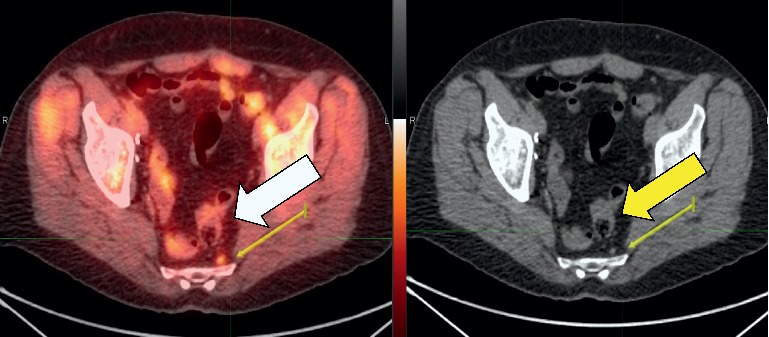
Images of a 68-year-old male with T3N0M0 prostate cancer. He had undergone radical prostatectomy, bilateral lymph node dissection, and salvage radiation therapy. He was referred for 18F-fluciclovine imaging with PSA rising to 0.7 ng/mL. The axial, fused PET/CT image on the left identifies a focus of enhanced 18F-fluciclovine uptake (white arrow) in the presacral region. The corresponding CT image on the right identifies a 6-mm lymph node metastasis (yellow arrow).